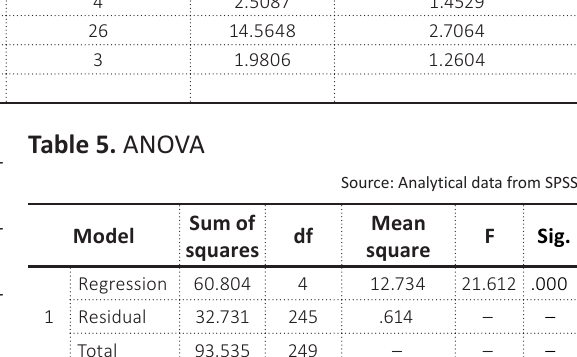
Table 3. Correlation matrix